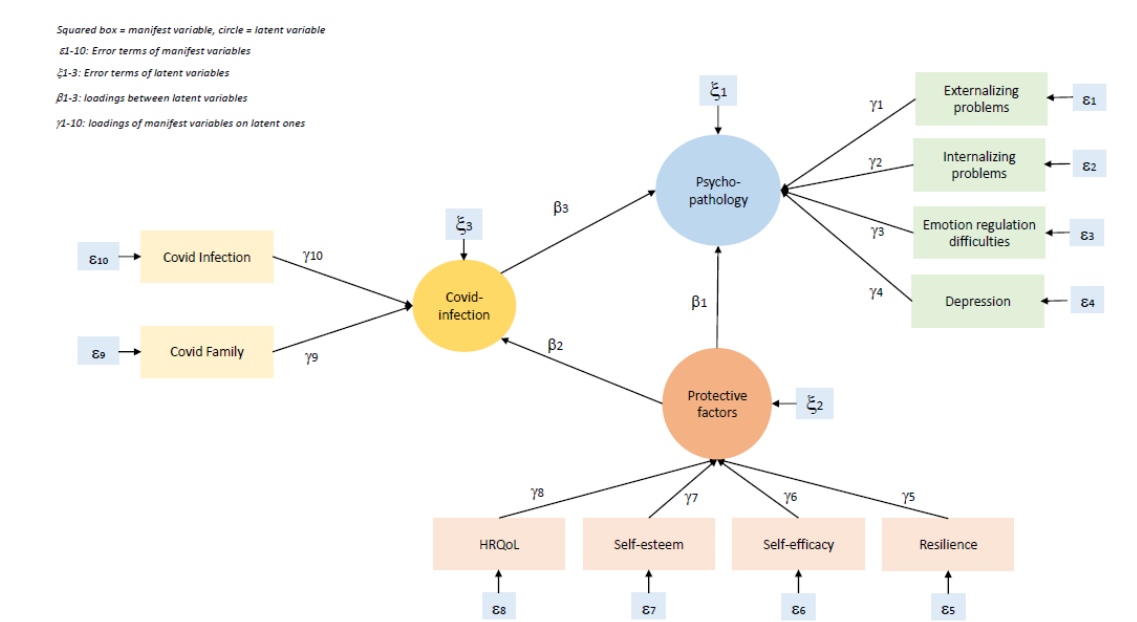
Figure 2. Hypothesized SEM with error terms.